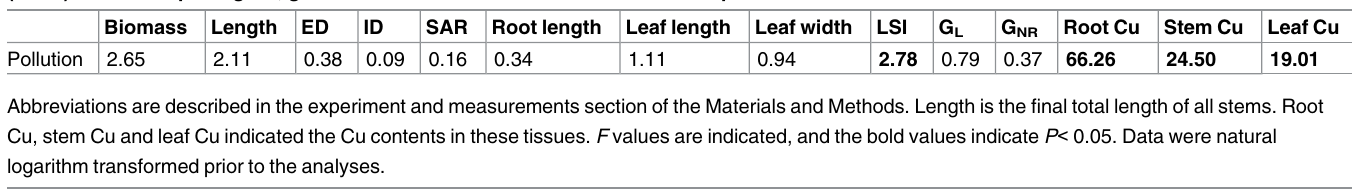
Table 2. Results of the one-way ANOVA showing the differences in plasticity (as calculated with Eq 1) among the terrestrial and aquatic habitats ( df = 1) for the morphological, growth and mechanical traits of Alternanthera philoxeroides . Biomass Length ED ID